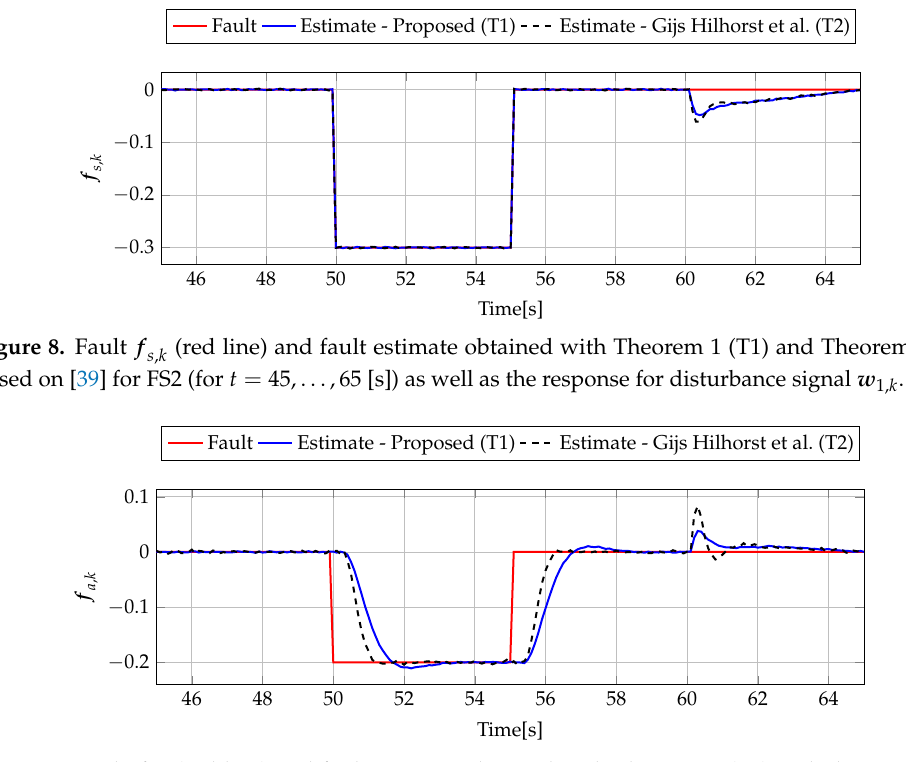
Figure 9. Fault f (red line) and fault estimate obtained with Theorem 1 (T1) and Theorem 2 (T2) a , k based on [39] for FS3 (for t = 45, . . . ,65 [s]) as well as the response for disturbance signal w 1, k .